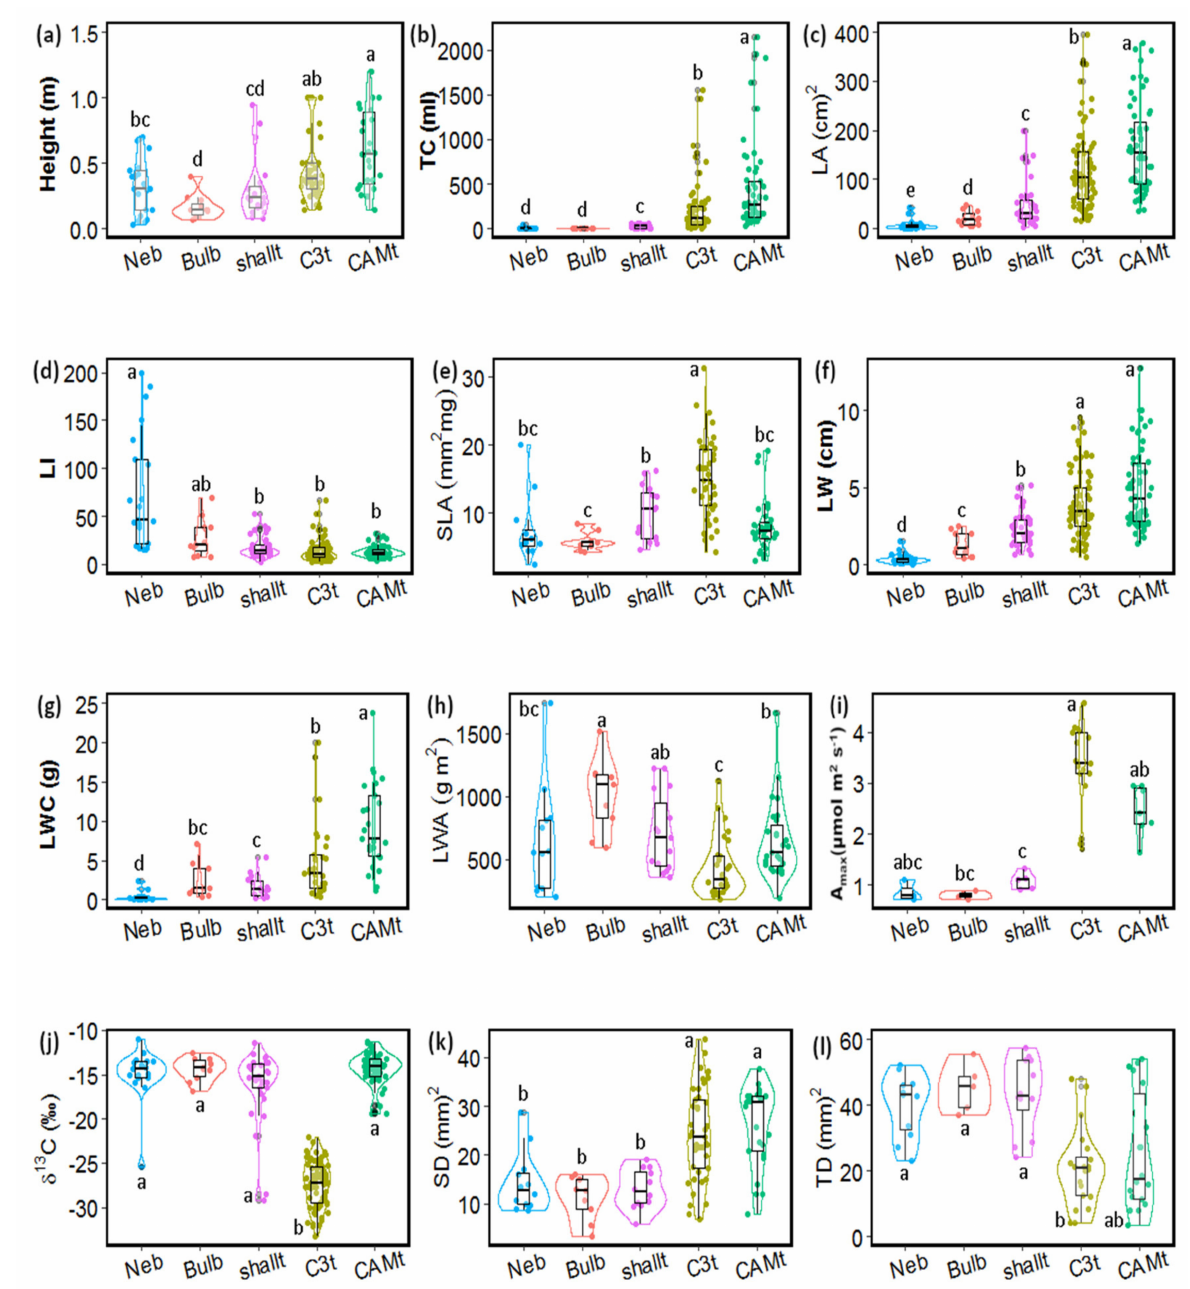
Figure 2. Comparison of functional traits between five functional groups of epiphytic Bromeliaceae, showing mean values for each species. ( a ) Height = adult plant height; ( b ) TC = tank capacity; ( c ) LA = leaf area; ( d ) LI = leaf index; ( e ) SLA = specific leaf area; ( f ) LW = leaf width; ( g ) LWC = total leaf water content; ( h ) LWA = leaf water content on area basis; ( i ) A max = light saturated photosynthetic rate per leaf area; ( j ) δ 13 C = leaf carbon isotope signature; ( k ) SD = stomatal density; and ( l ) TD = leaf trichome density per functional group. Neb = nebulophytes; Bulb = pseudobulbs; ShallT = shallow tanks; C3T = C 3 tanks and CAMT = CAM tanks. Groups with different letters are significantly different (Wilcoxon and Tukey HSD post-hoc tests, p < 0.05). Extreme data points were not depicted in the graph to help the visualization of the data for: LA, LWC, SD, and